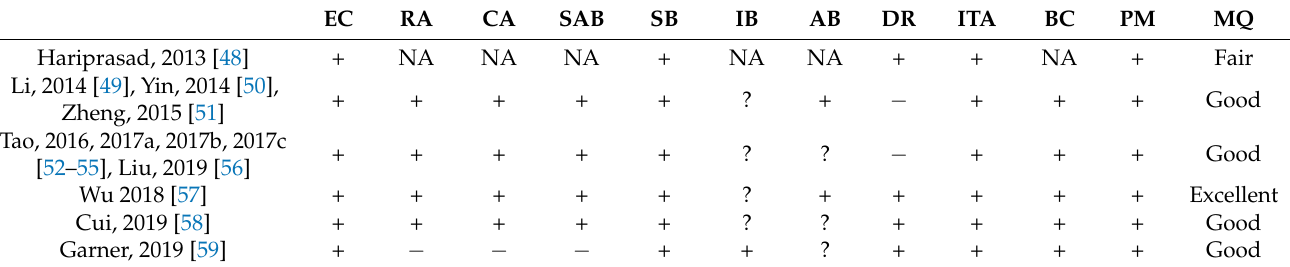
Table 4. Quality assessment of the included intervention